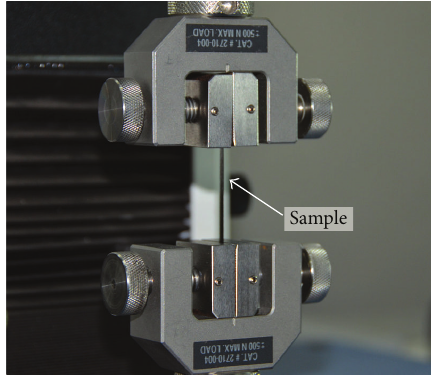
Figure 2: Sample under uniaxial tension.